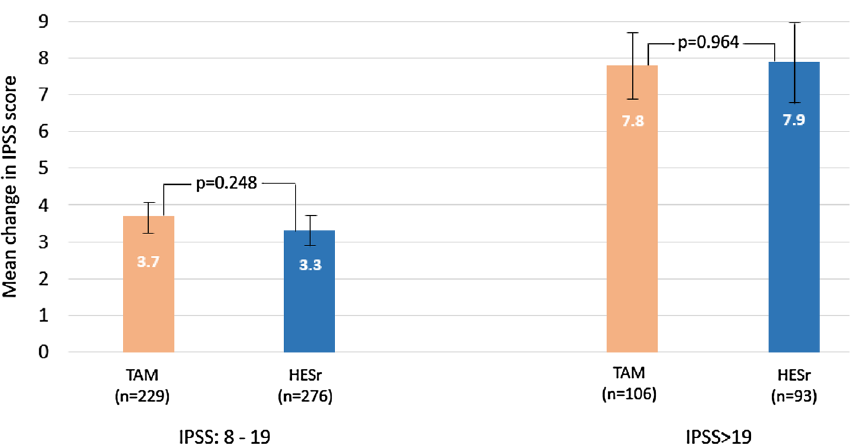
Figure 2. Mean change (95% CI) in IPSS total score from baseline to 6 months for the treatment groups based on baseline symptom severity (iterative matching sample). TAM: tamsulosin; HESr: hexanic extract of Serenoa repens; IPSS: International Prostate Symptom